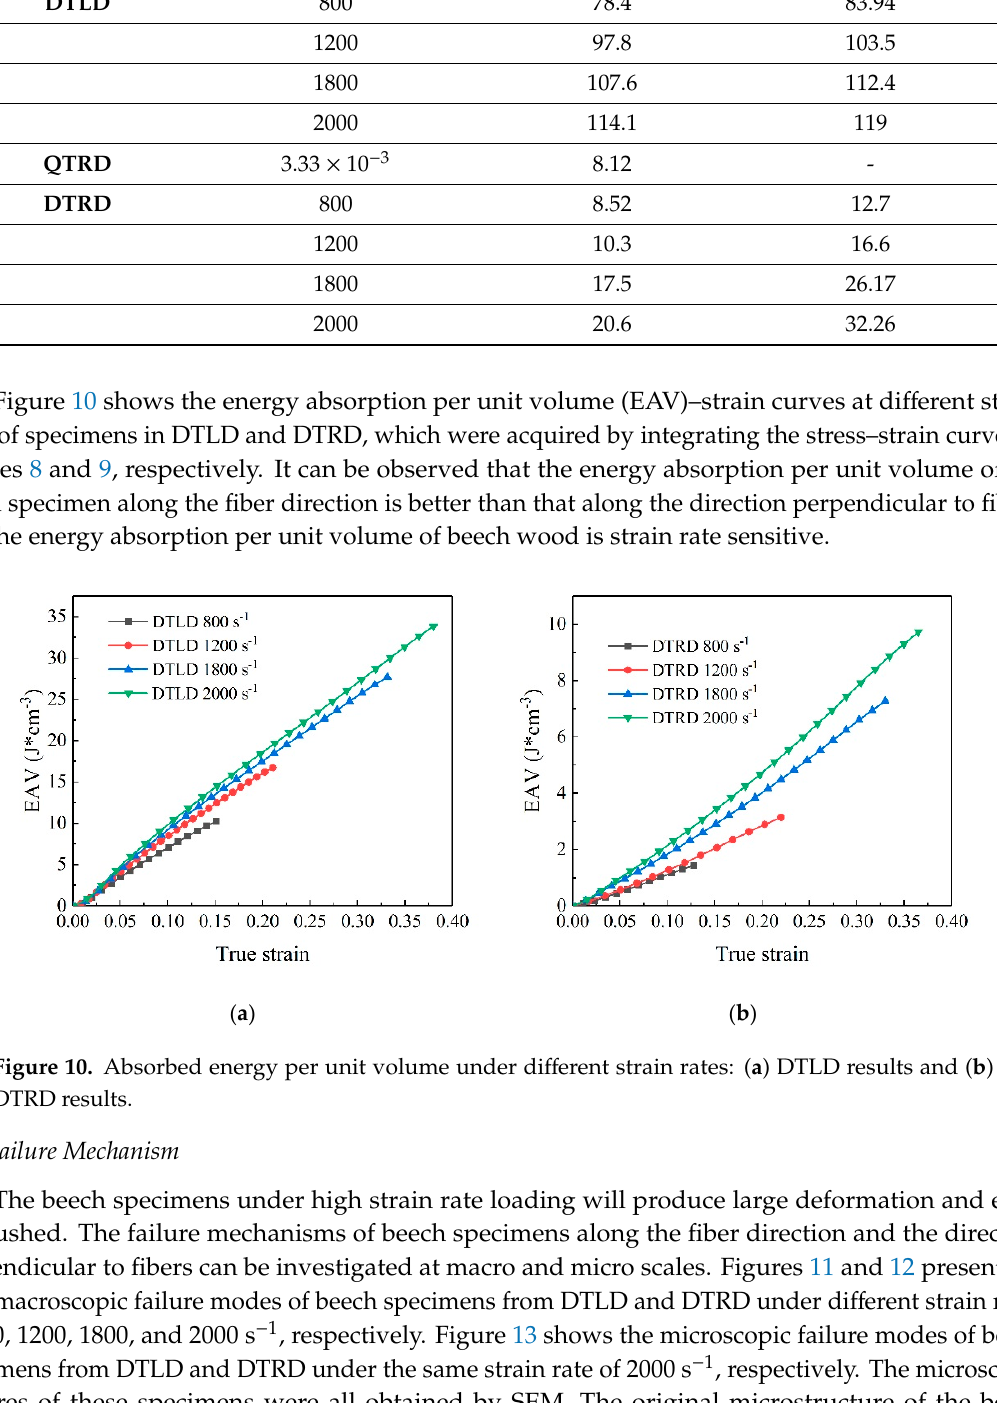
( d ) Figure 11. Final failure shapes of DTRD under different strain rates of ( a ) 800 s − 1 , ( b ) 1200 s − 1 , ( c ) 1800 s − 1 , and ( d ) 2000 s − 1 .